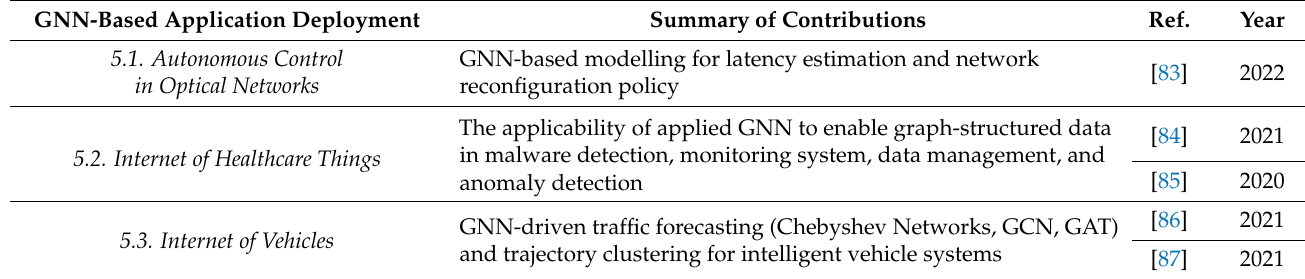
Table 7. Summary of Selected Works in GNN-Based Application